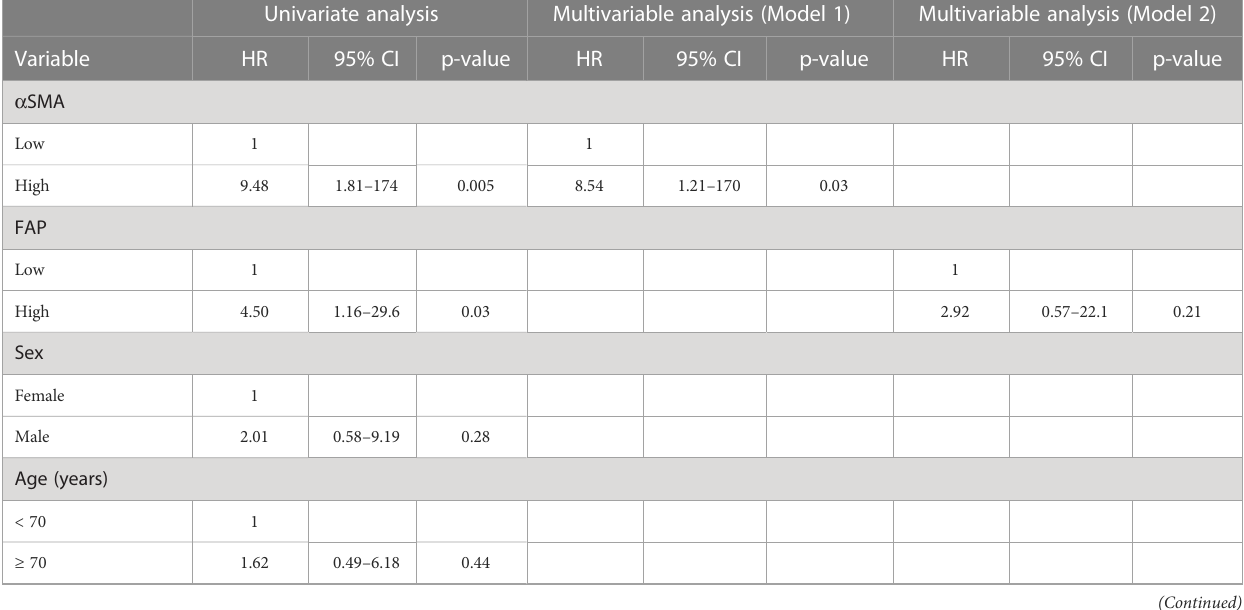
TABLE 4 Univariate and multivariable analyses of prognostic factors associated with disease-speci fi c survival. Univariate analysis Multivariable analysis (Model